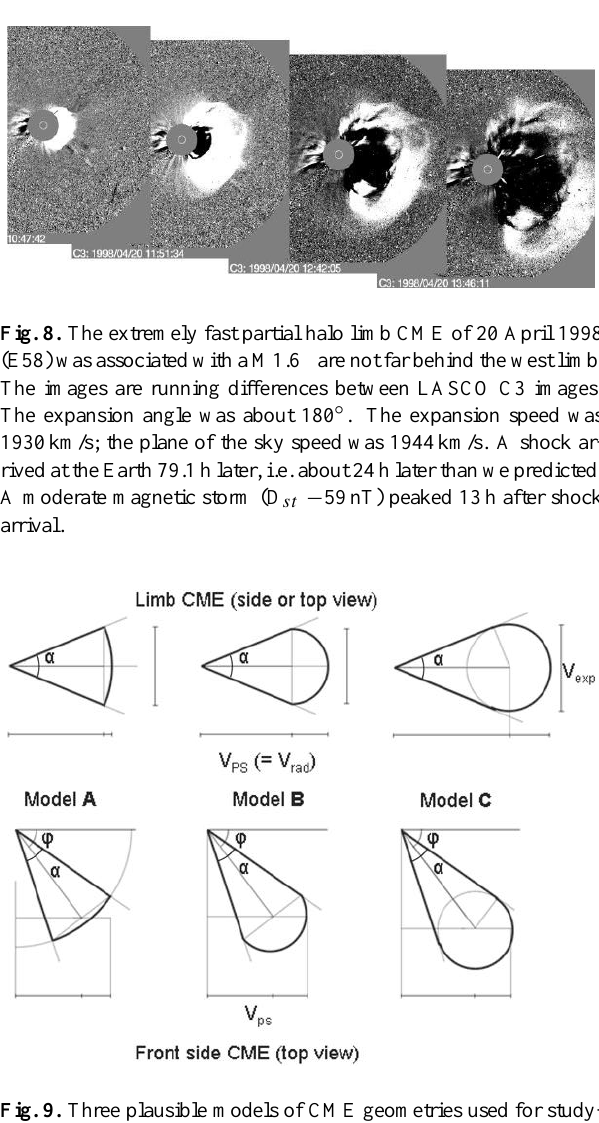
Fig. 9. Three plausible models of CME geometries used for studying the ratio between V exp and V rad and their relation to the plane of the sky speed V PS . The front surface is assumed to be a sphere section, either with the Sun in the center (A), or a half sphere sitting on top of a cone (B), or a sphere dropped into a cone (like a real ice cream ball, such that the ball surface touches the sphere tangentially, C). The cone angle a (i.e., the full angle between between the outer edges of opposing flanks of CMEs) and the radial speed V rad are assumed to be constant with time. Thus, the linear dimensions are proportional to the speeds V exp and V rad . The upper panels apply to limb CMEs, viewed from the top or from the side. For the lower panels, the CMEs are off-pointed by an angle f with respect to the plane of the sky.